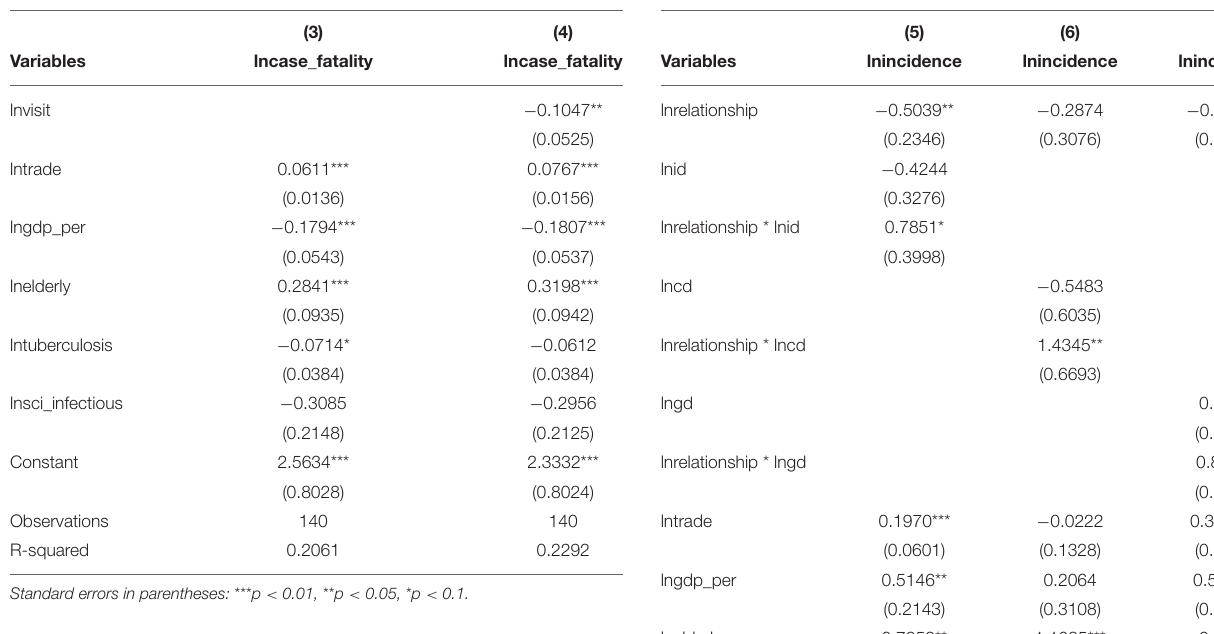
TABLE 4 | Robustness test. TABLE 5 | Moderating effects